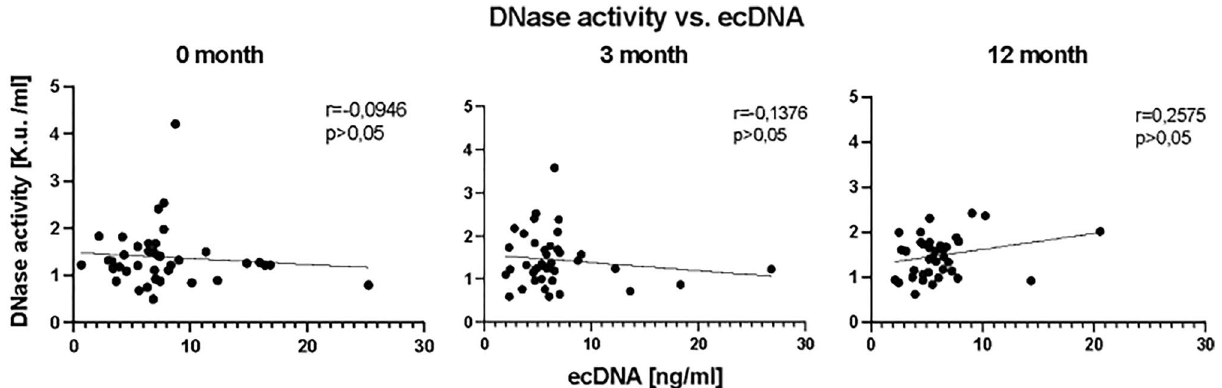
Figure 10. Correlations between DNase activity and ecDNA in plasma in specific time